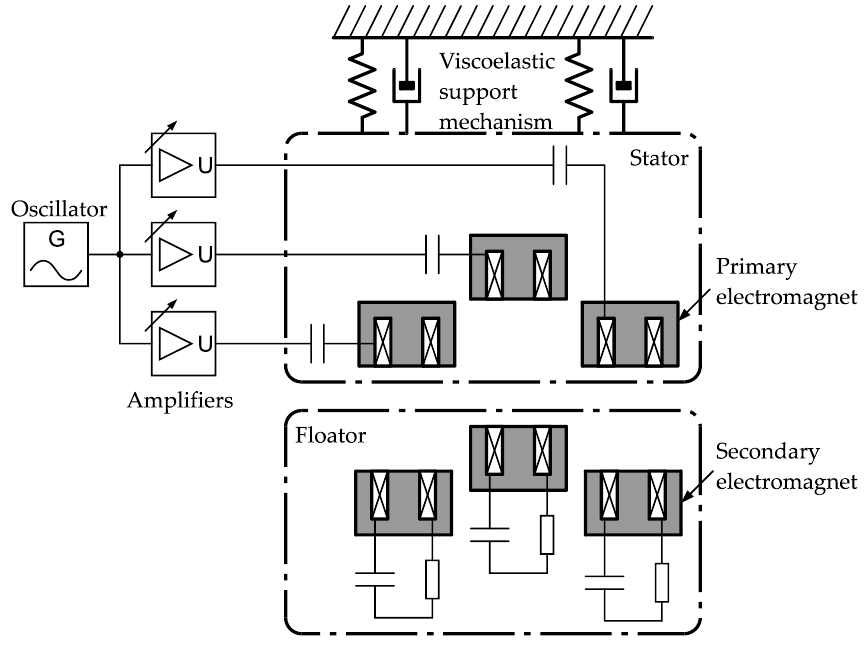
Figure 12. Schematic view of experimental setup. The dash–dot rounded squares represent the mechanical parts of the stator and floator.